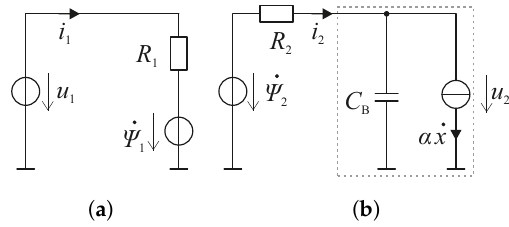
Figure 5. Equivalent circuits for electrical modelling. ( a ) primary part with power electronics; ( b ) secondary part with piezoelectric load (dashed).